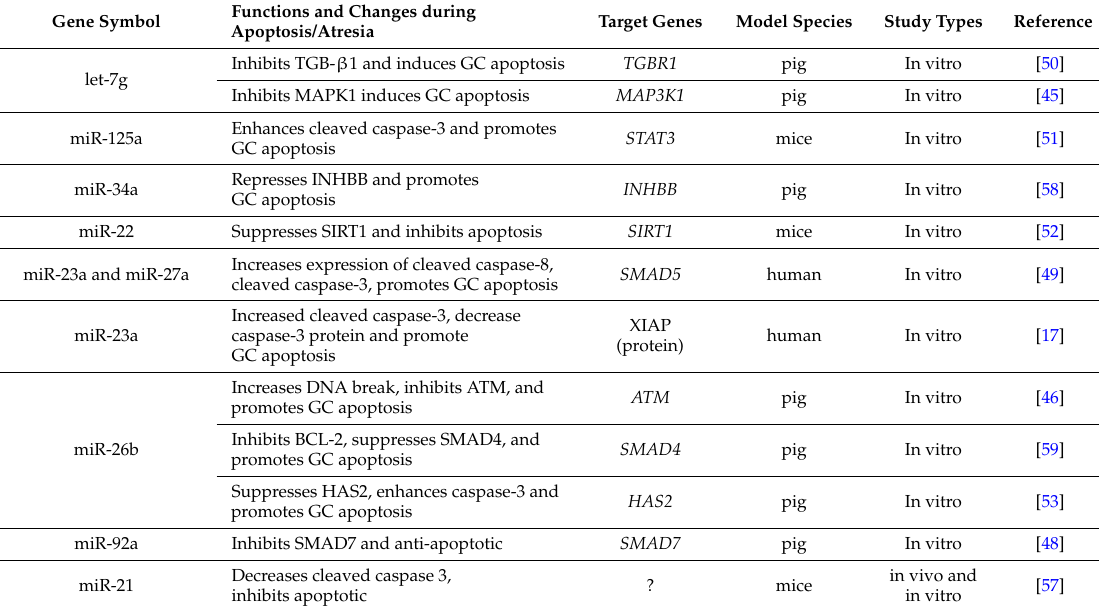
Table 1. Summary of role miRNAs in granulosa cell (GC) apoptosis: targeted genes, model species, study platform used and changes